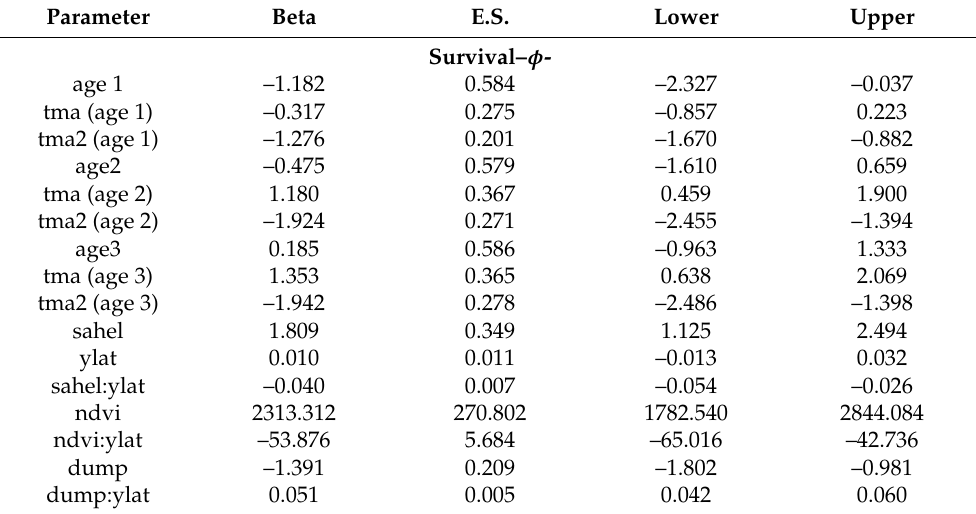
Table 3. Beta estimates for survival – φ – and recapture -p- (i.e., logit link function parameters) derived from the best fit model (lower QAICc), see Table 2. Standard Error (ES) and Confidence Intervals